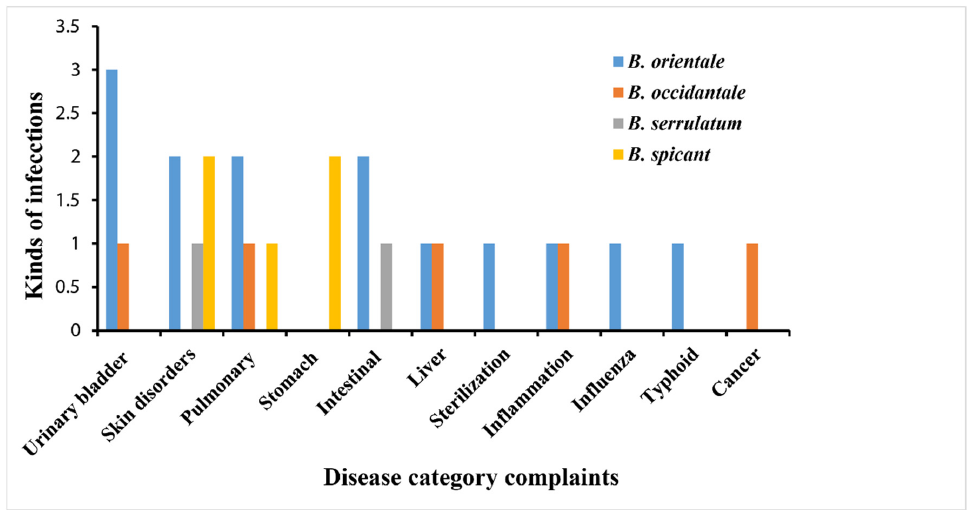
Figure 3. Traditional herbal uses of Blechnum species.